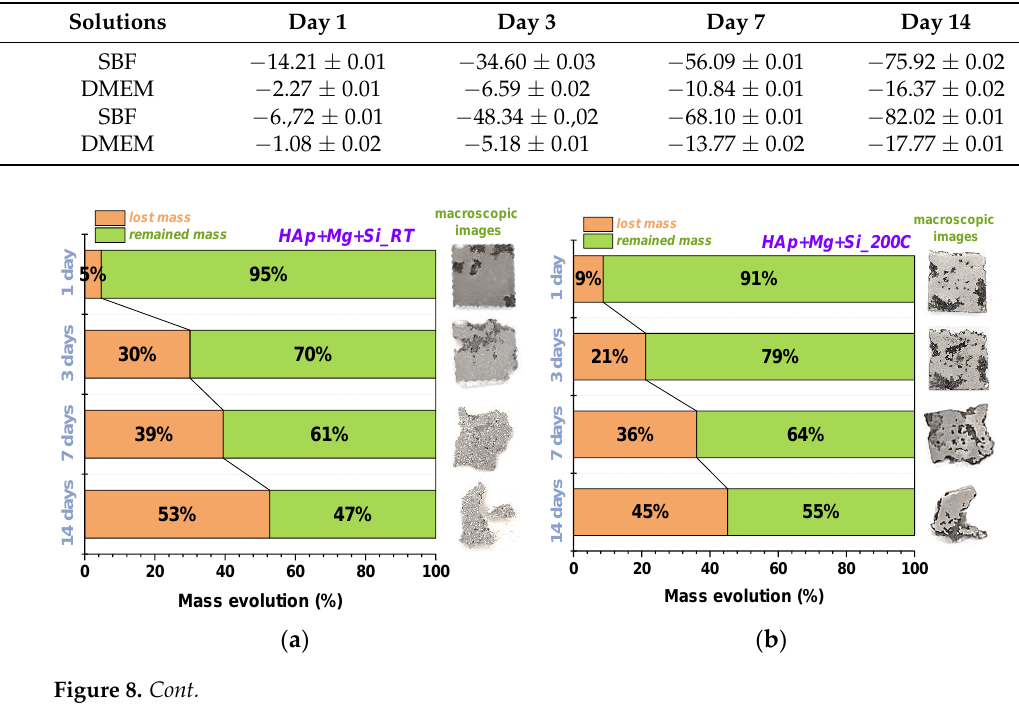
Table 5. Mass loss of the coatings obtained in SBF and DMEM solutions.